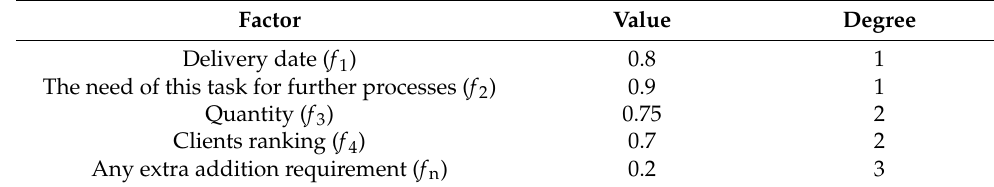
Table 2. Values of selected factors. Factor Value Degree